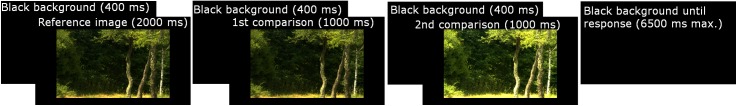
Stimuli sequence of an example trial.The reference image was always simulated rendered by D67. In condition 1 the CCT of the illumination changed in one of the intervals; in condition 2 the intensity of the illumination changed in one of the intervals. The observer’s task was to identify which of the intervals was different from the reference. Here a luminance change in the second image presentation is illustrated.